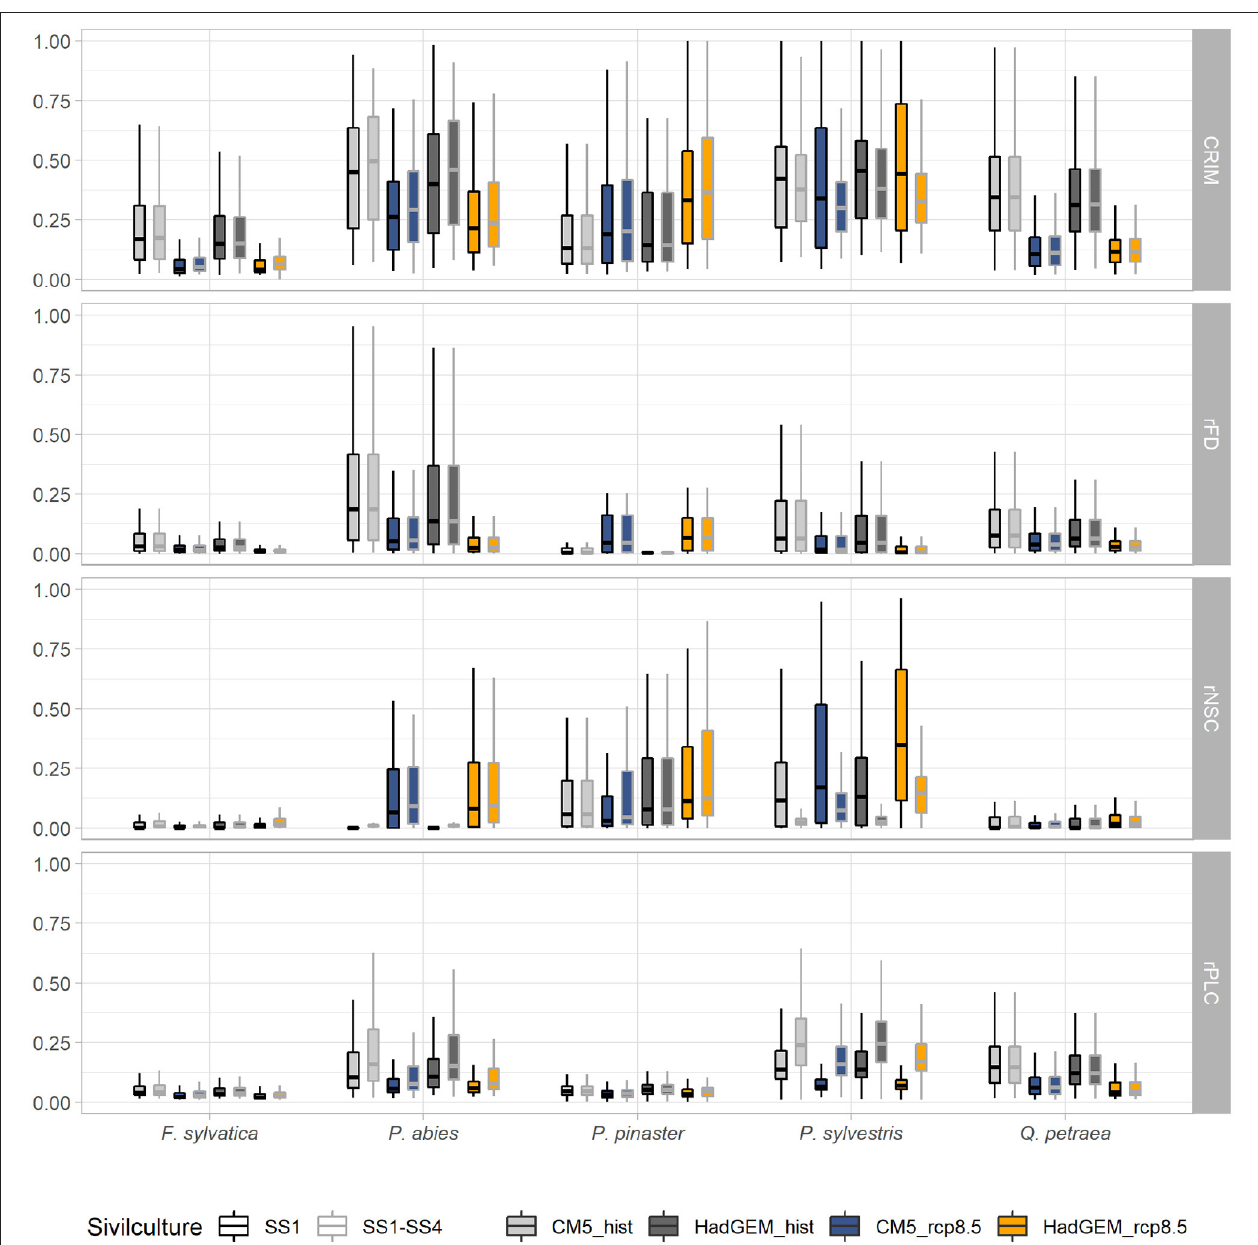
FIGURE 5 | Variation of the mean values of mortality risk indices ( CRIM , rFD max , rNSC , and rPLC ) under two current (CM5-hist in light gray and HadGEM-hist in dark gray) and two future (CM5-8.5 in blue and HadGEM-8.5 in orange) climatic scenarios. Each scenario with locally prescribed silviculture (i.e., four possible silvicultural systems) is represented with gray whisker box contouring, and can be compared to its reference without management (i.e., SS1), with black contouring. See legend of Figure 3 for whisker